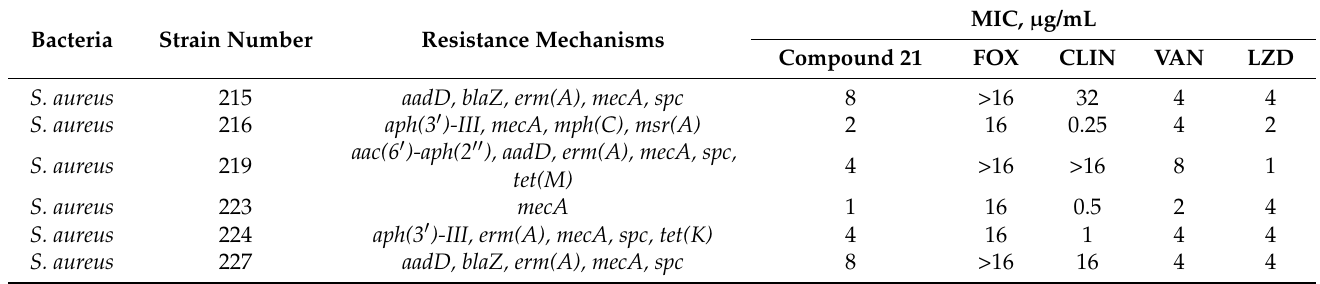
Table 1. The antimicrobial activity of 5-oxopyrrolidine derivative 21 against multidrug-resistant and vancomycin intermediate resistant Staphylococcus aureus strains. The data expressed in the table represents minimal inhibitory concentration from 3 technical